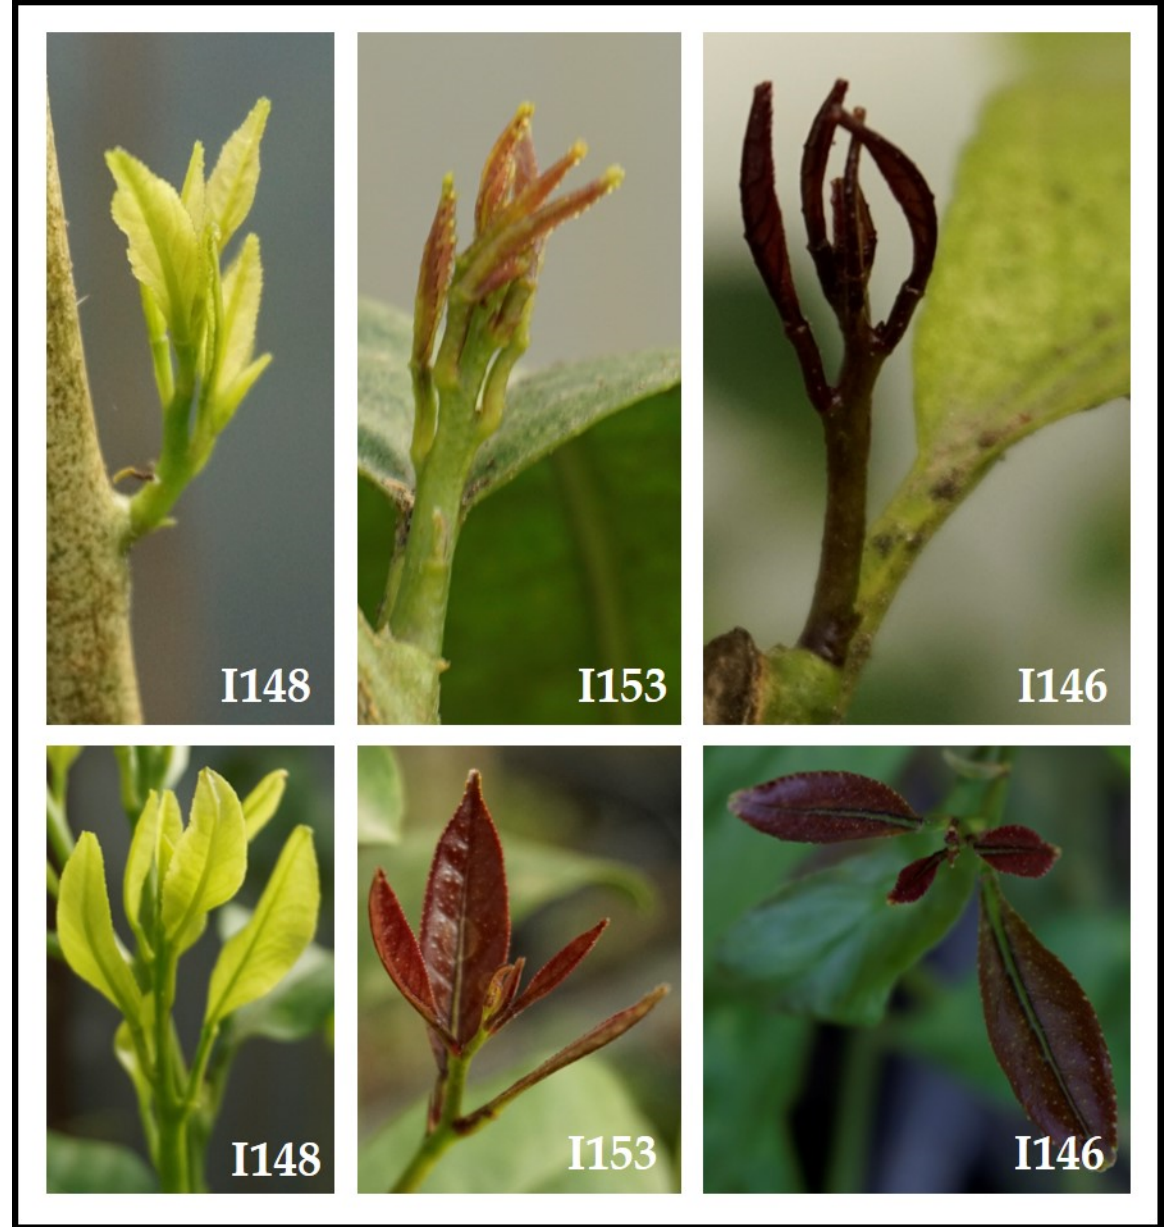
Figure 4. Example of character segregation in the population ‘Interdonato’ lemon × ‘Femminello Siracusano 2kr’ lemon: anthocyanin pigmentation in young shoots of three different hybrids (from left: I148, I153, and I146) in two different development stages.